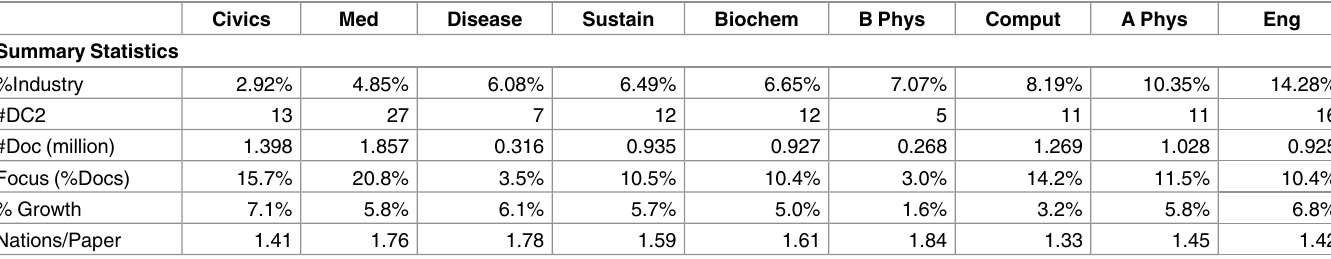
Table 4. Characteristics of the nine researchstrategies identified using factor analysis.